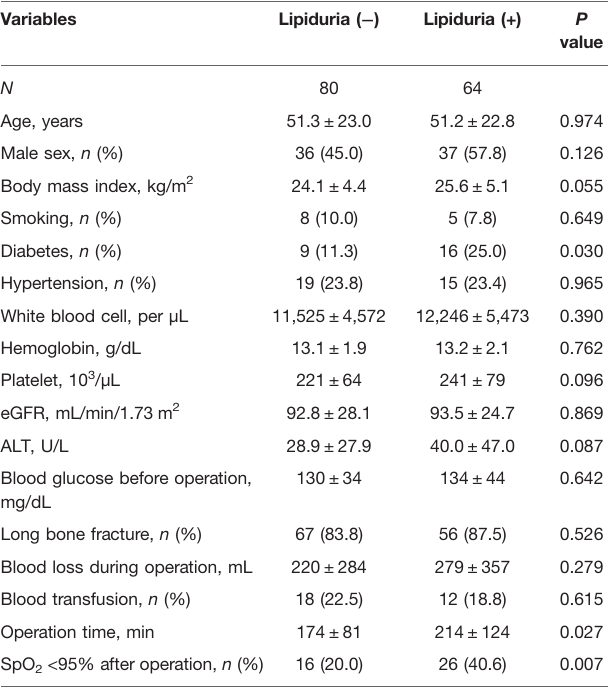
TABLE 1 | Characteristics of the study population according to postoperative